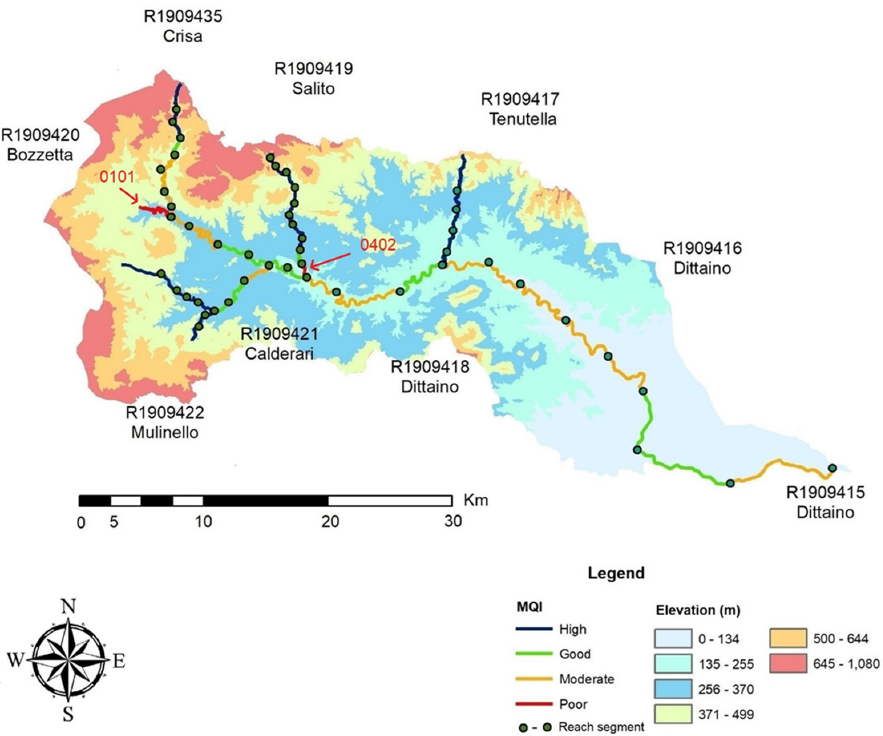
Figure 9. Elevation of the Dittaino basin, hydrograph segmentation and MQI evaluation results, and poor MQI reach number identification.